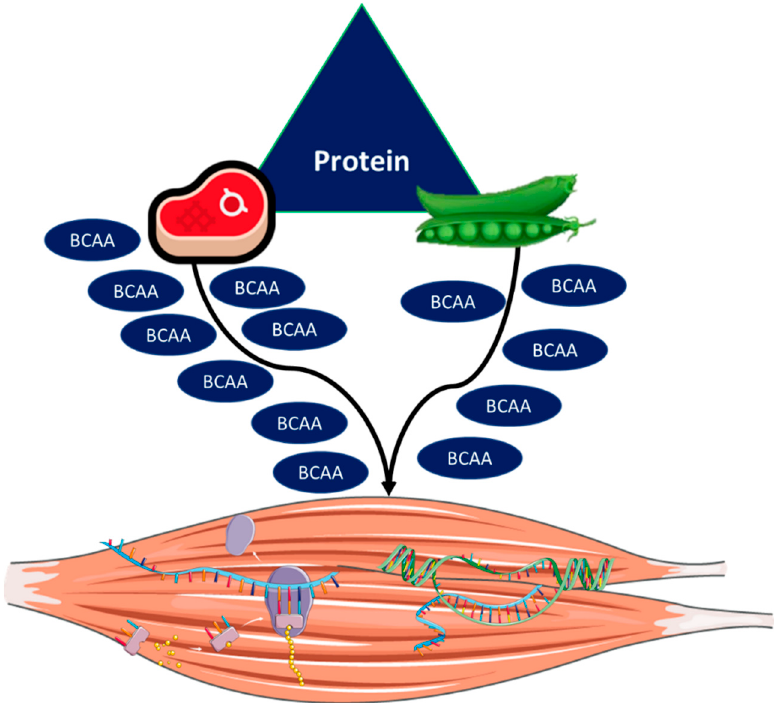
Figure 4. Animal- and plant-based protein sources. Animal-based plant protein is expected to have a higher content of branched-chain amino acids (BCAAs), thereby evoking greater stimulation of anabolic pathways and muscle protein synthesis than plant-based protein.